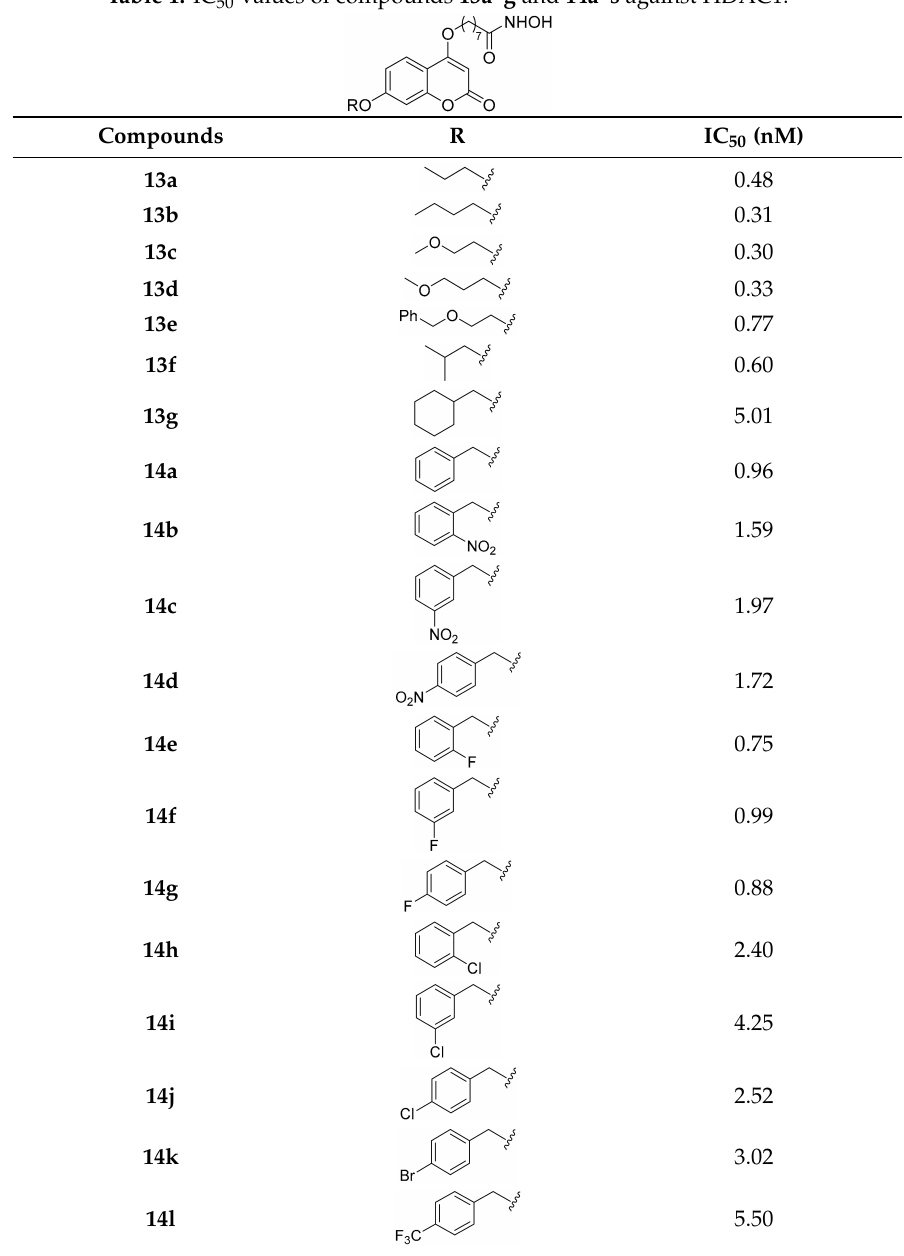
Table 1. IC 50 values of compounds 13a – g and 14a – s against